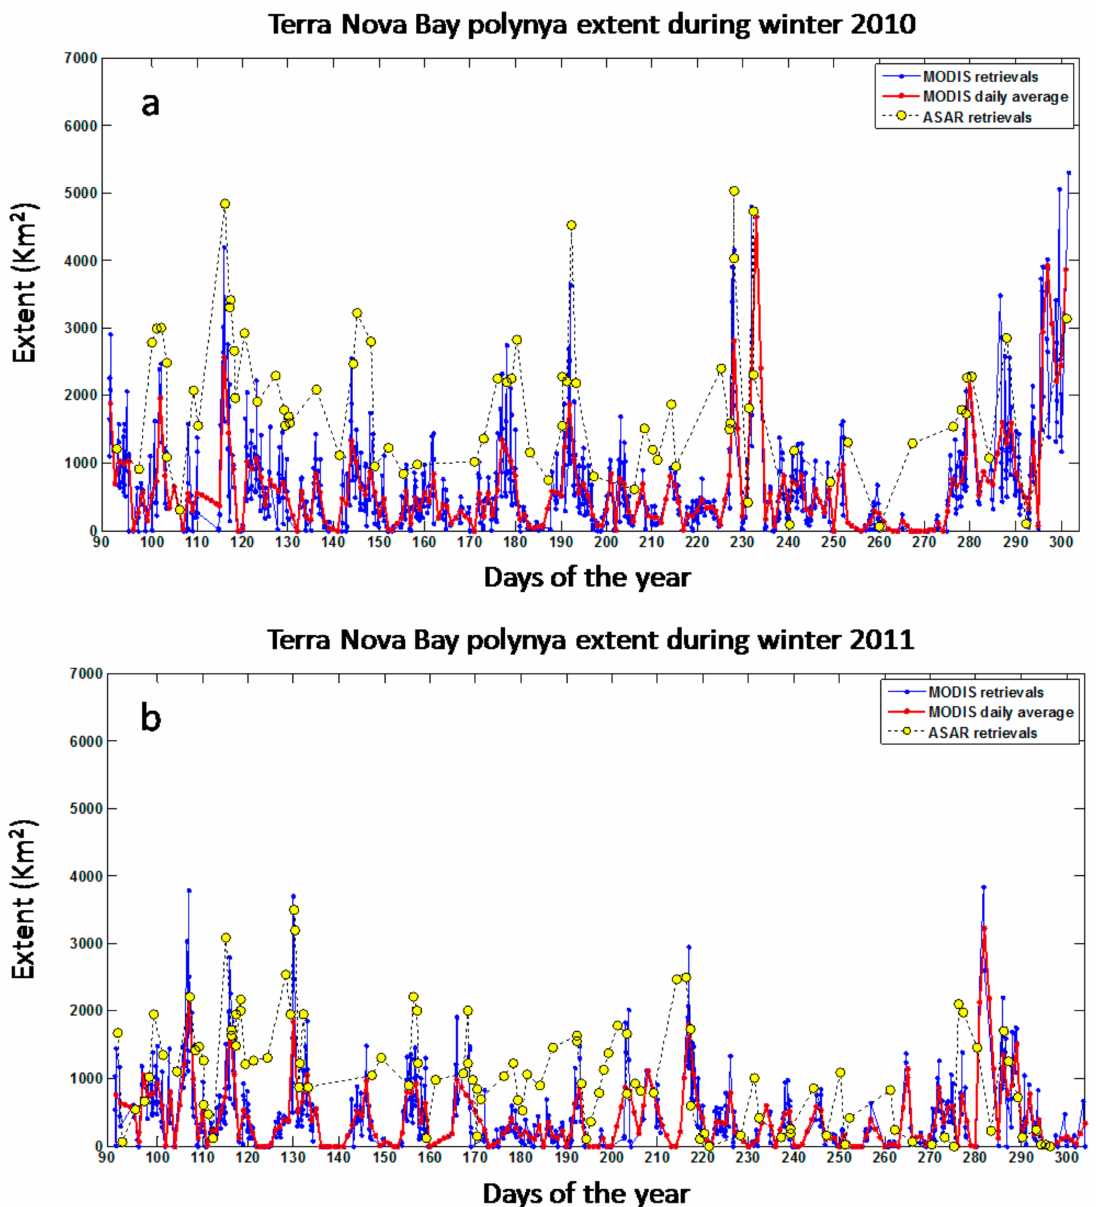
Figure 3. Terra Nova Bay polynya evolution during 2010 ( a ) and 2011 ( b ) winter periods (1 April to 31 October) retrieved through the analysis of available MODIS level-1b scenes (blue); MODIS retrievals daily average (red dots) is also shown. Yellow circles indicate co-located ASAR derived